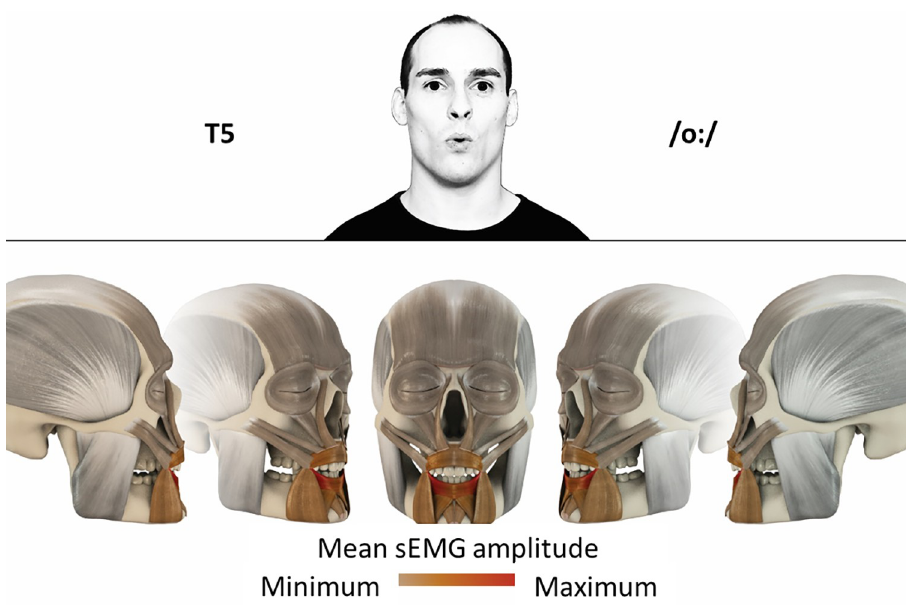
Fig 6. Color-coded facial muscle activation pattern of task T5. Pronouncing the German vowel: O/o ː /. Animation by Jonas Laustro¨er.